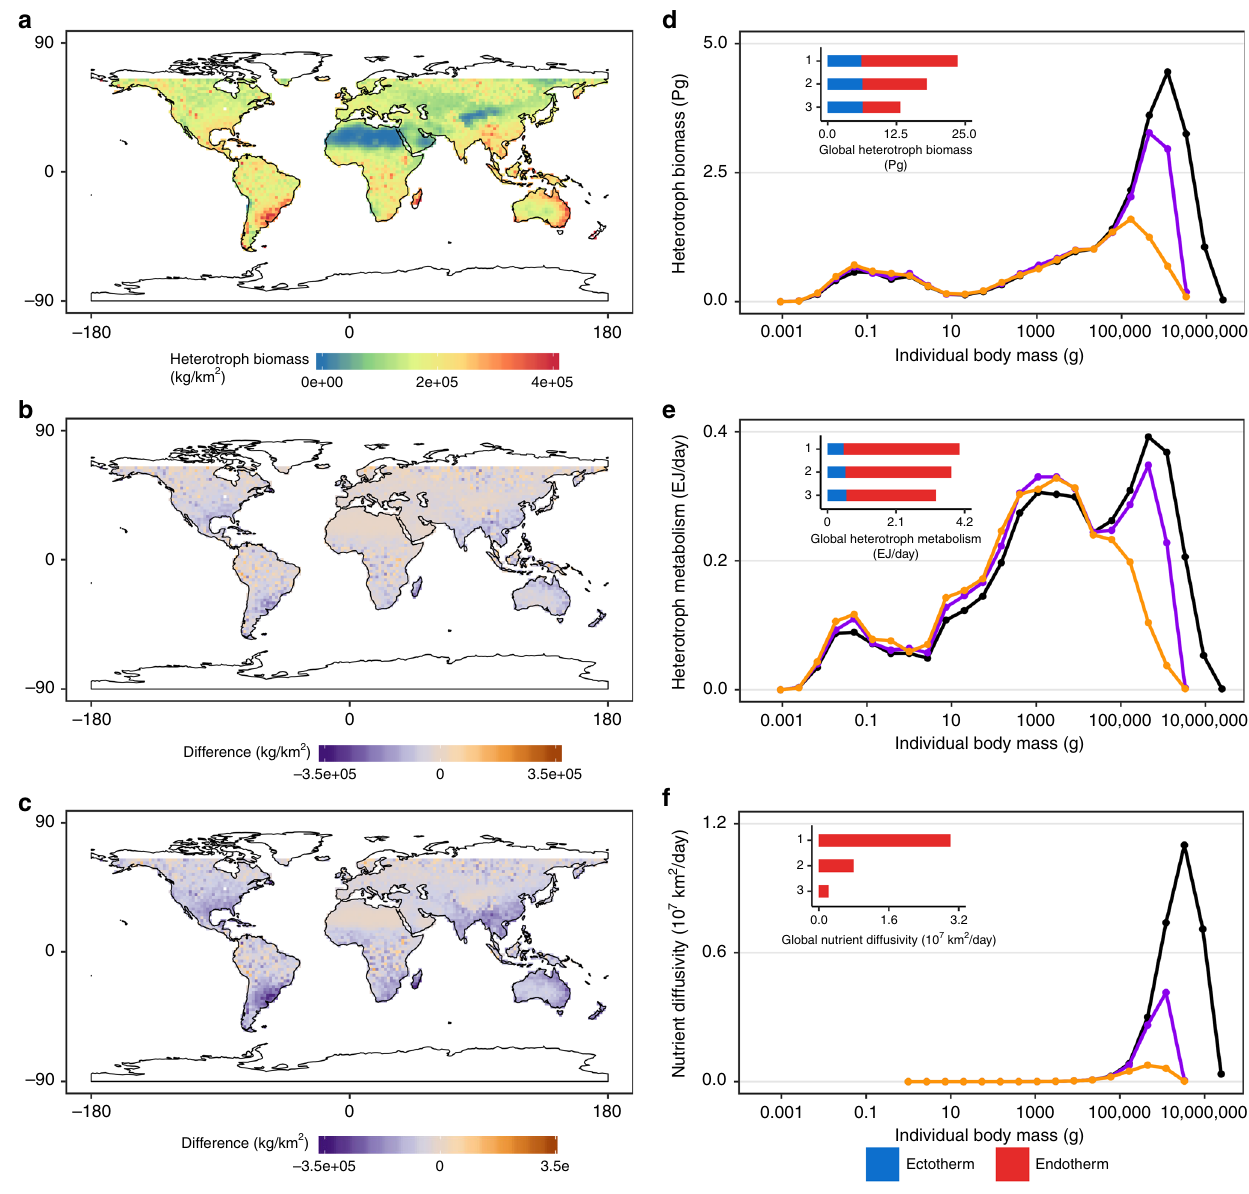
Fig. 5 The continued global downsizing of large animals results in reductions in terrestrial biosphere biomass, metabolism, and fertility. The annual mean heterotrophic community biomass from three ensemble experiments using the General Ecosystem Model (GEM) mapped spatially showing a the Pleistocene world, b the difference between the Pleistocene world and Modern world and c Future world. The implications of this downsizing for the functioning of the biosphere are measured using the annual mean of the GEM experiments for the three ecosystem-level measures; d heterotrophic biomass, e heterotrophic metabolism and f nutrient diffusivity summarized into 25 mass bins. The inset graphs display the global total for each metric and are numbered (1) Pleistocene, (2) Modern and (3) Future world respectively. Global map from the 110 m land polygon shape fi le from Natural Earth